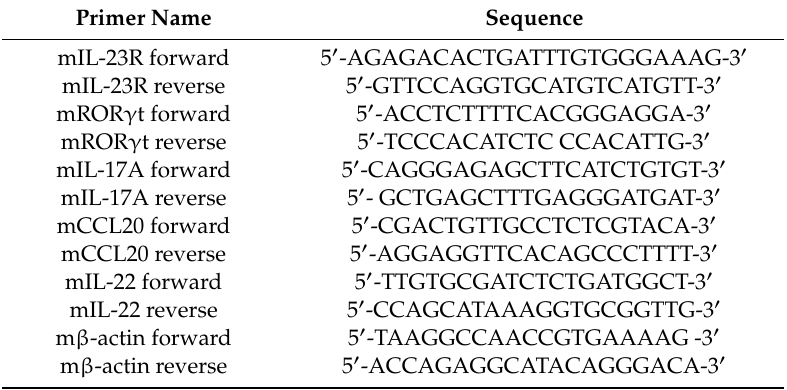
Table 2. Quantitative real-time polymerase chain reaction (qPCR) primer